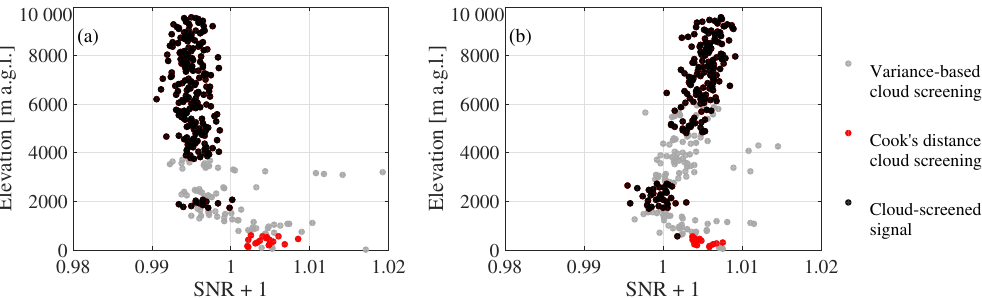
Figure 5. Two example vertical profiles of SNR with different background shapes measured by a Halo Doppler lidar on 21 May 2014 at (a) 07:24:24UTC and (b) 08:33:35UTC in Hyytiälä, Finland, illustrating the results of the two-cloud-screening